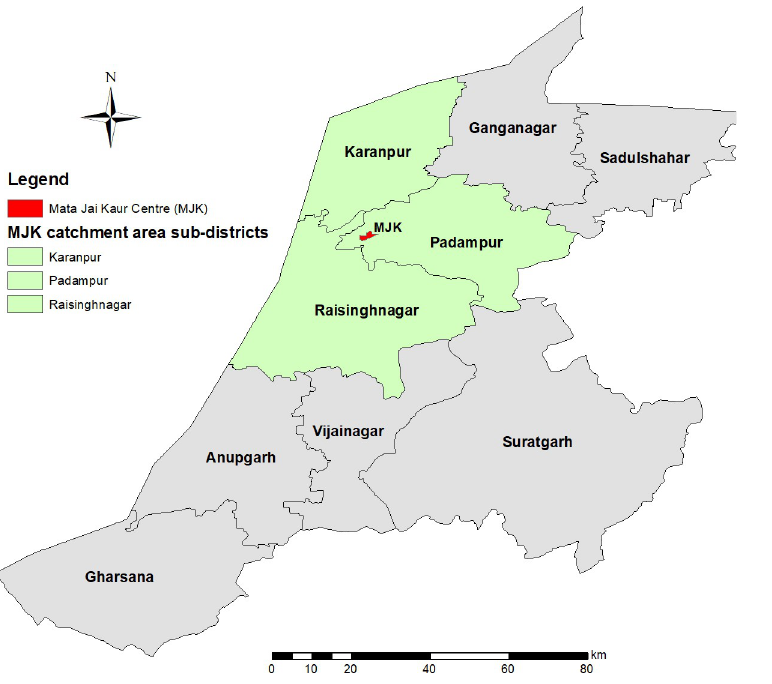
Fig 2. Sub-districts ( tehsils ) and MJK catchment area in Sri